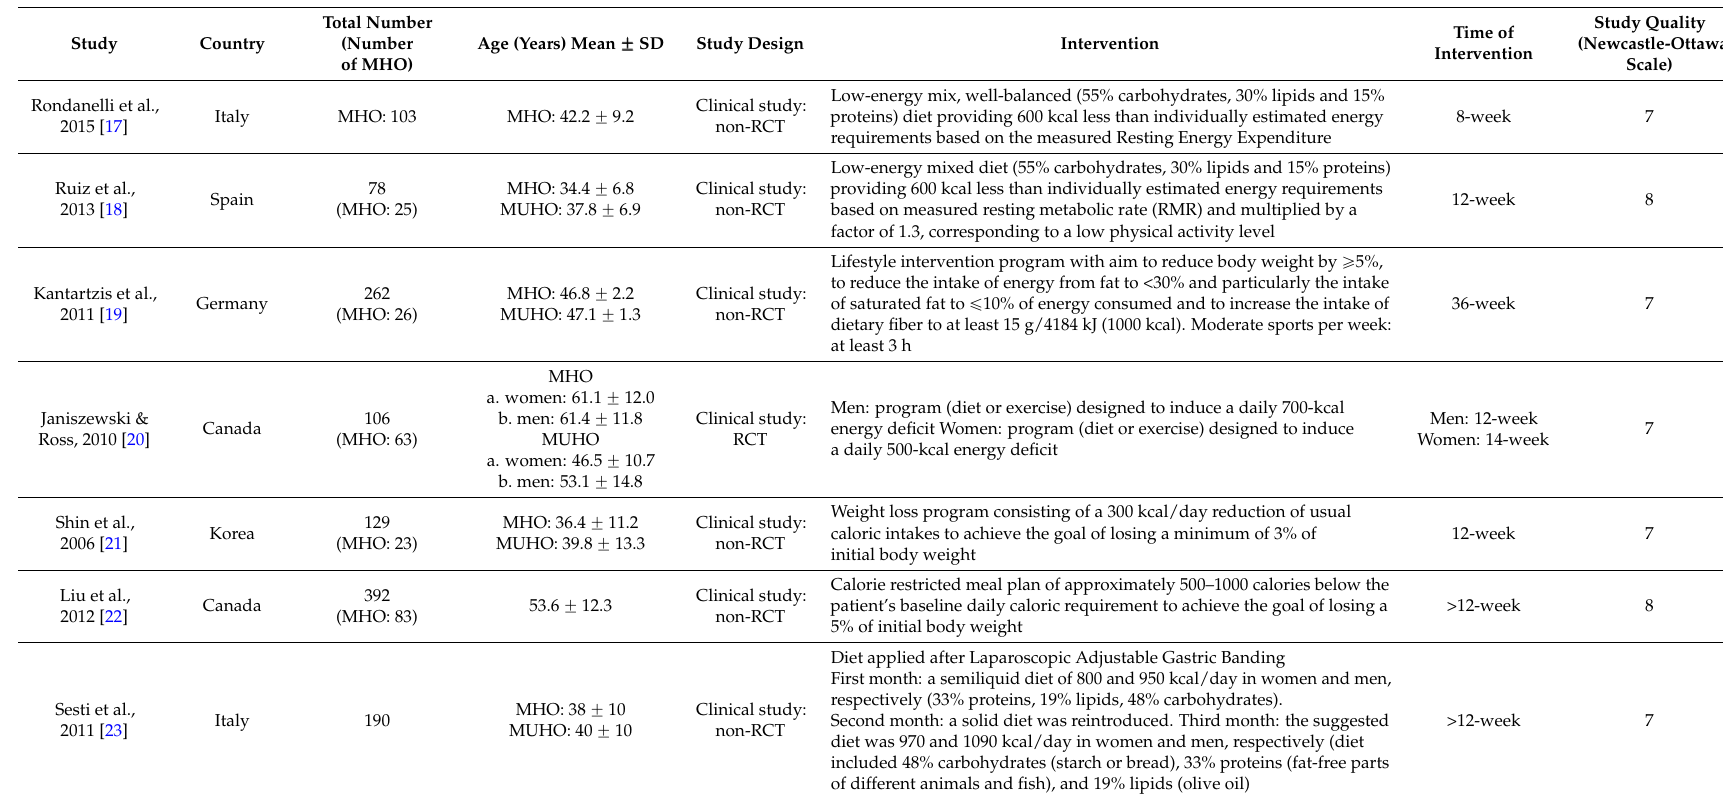
Table 1. Characteristics of the included studies and study